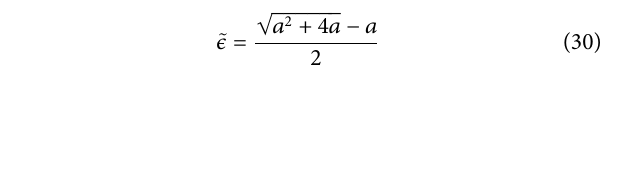
TABLE 1 | Radar, target and clutter parameters used in the stochastic geometry formulations and Monte Carlo simulations. Parameter Symbol